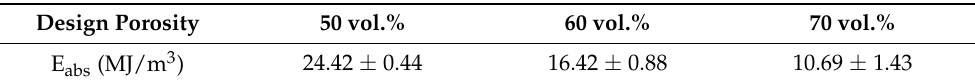
Table 4. Energy absorption values of the aluminium foams. Design Porosity 50